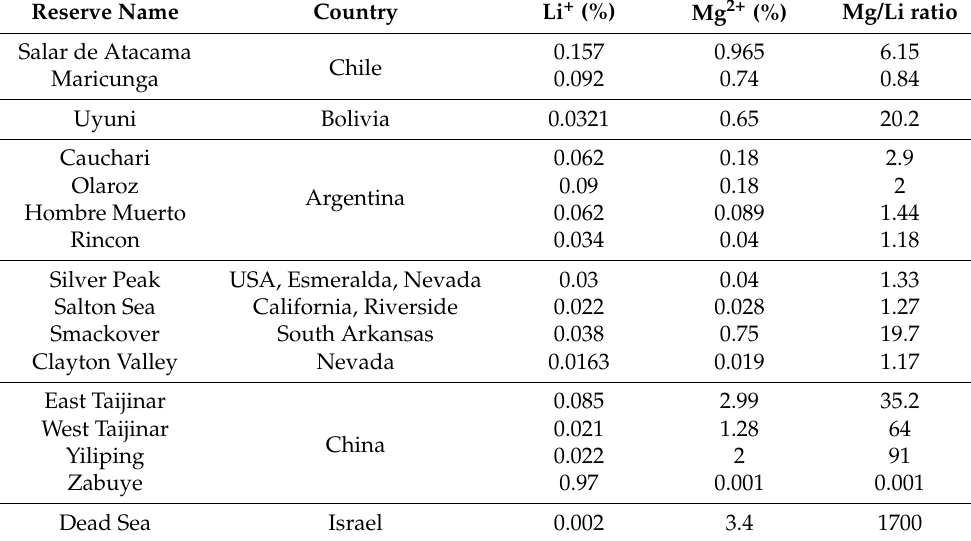
Table 5. Lithium and magnesium concentrations in some known